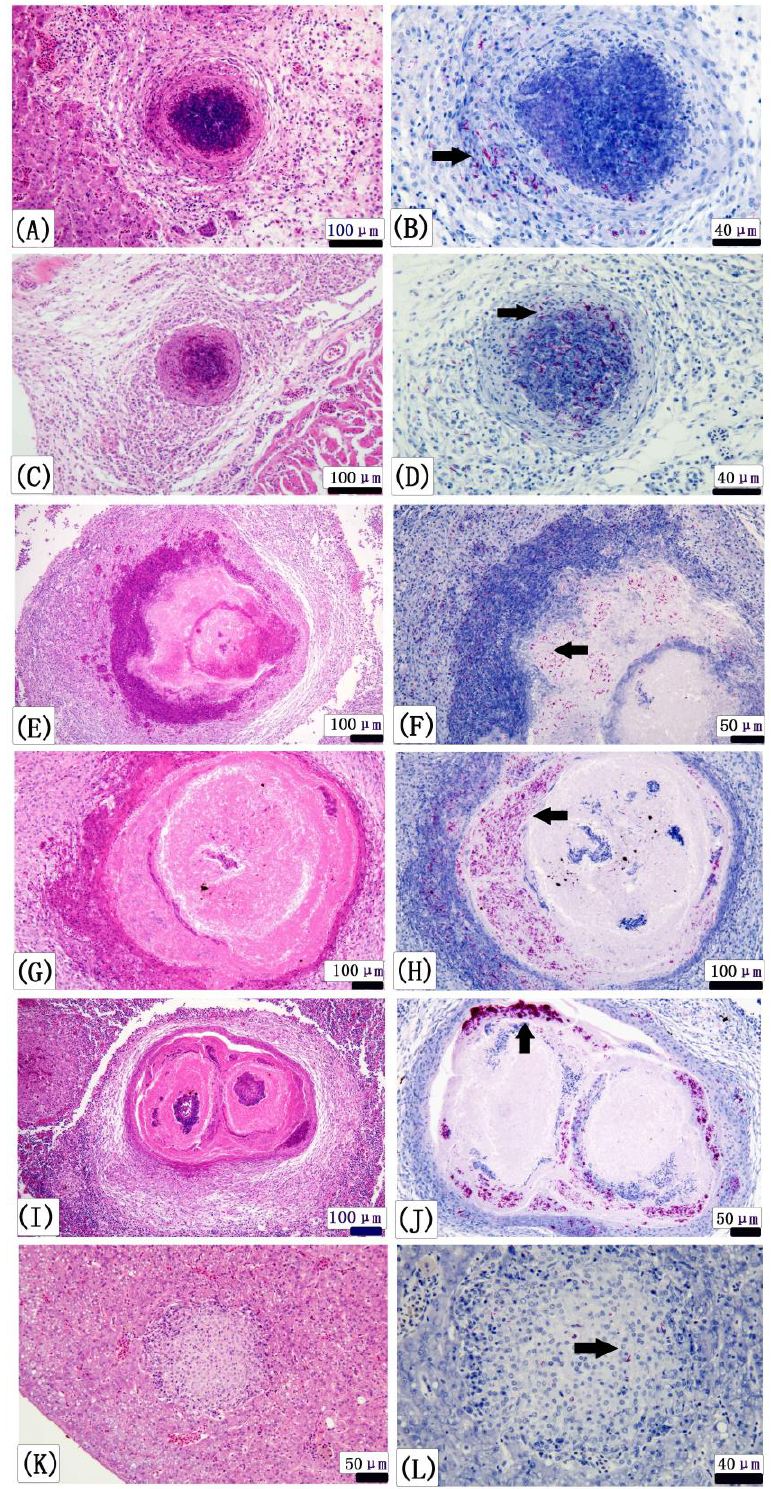
Figure 4. Histopathology of mycobacteriosis in Japanese seabass of natural and artificial infection. All histopathologic sections in the left column were subjected to H&E staining, and the corresponding sections in the right column were subjected to Z&N staining. ( A , C , E , G , I ) Granulomas in liver, heart, kidney, spleen, fusion of natural infection. ( K ) Spleen of artificial infection. ( B , D , F , H , J ) Numerous acid-fast bacilli in liver, spleen, kidney, heart and fusion of natural infection (arrow). ( L ) Numerous acid-fast bacilli in spleen of artificial infection (arrow).